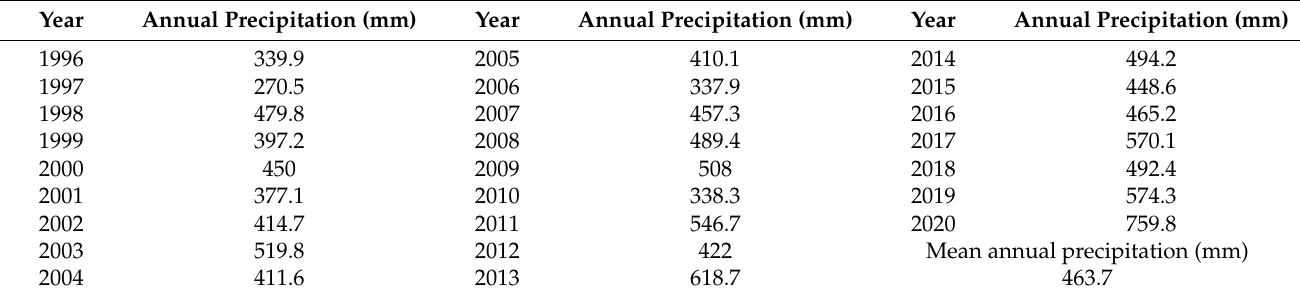
Table 3. Annual precipitation data of the study area.